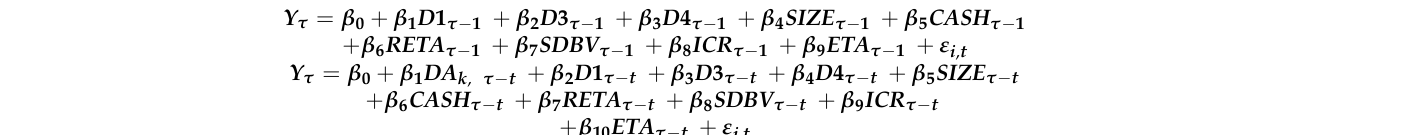
Table 9. Predictive capacity of discretionary accruals for insolvent